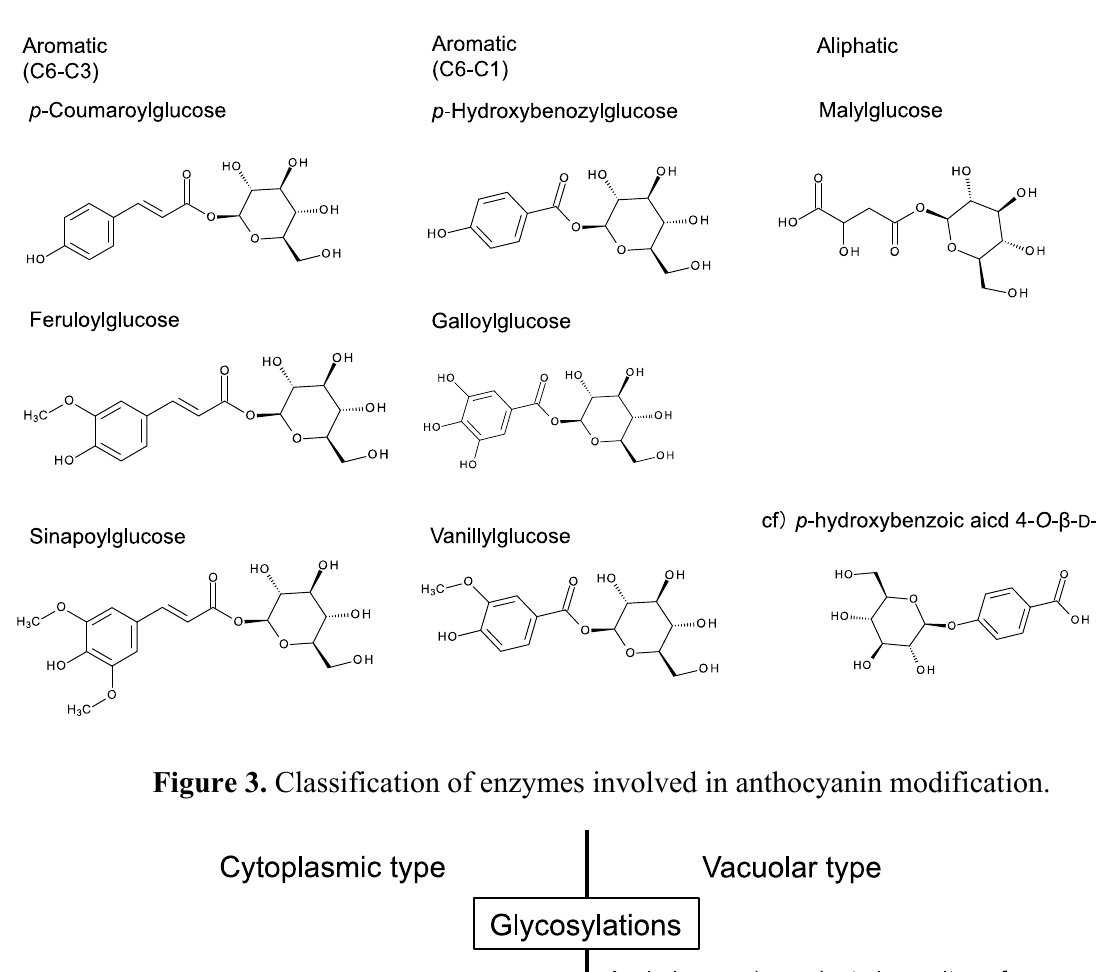
Figure 2. Representative chemical structures of acyl-glucoses.